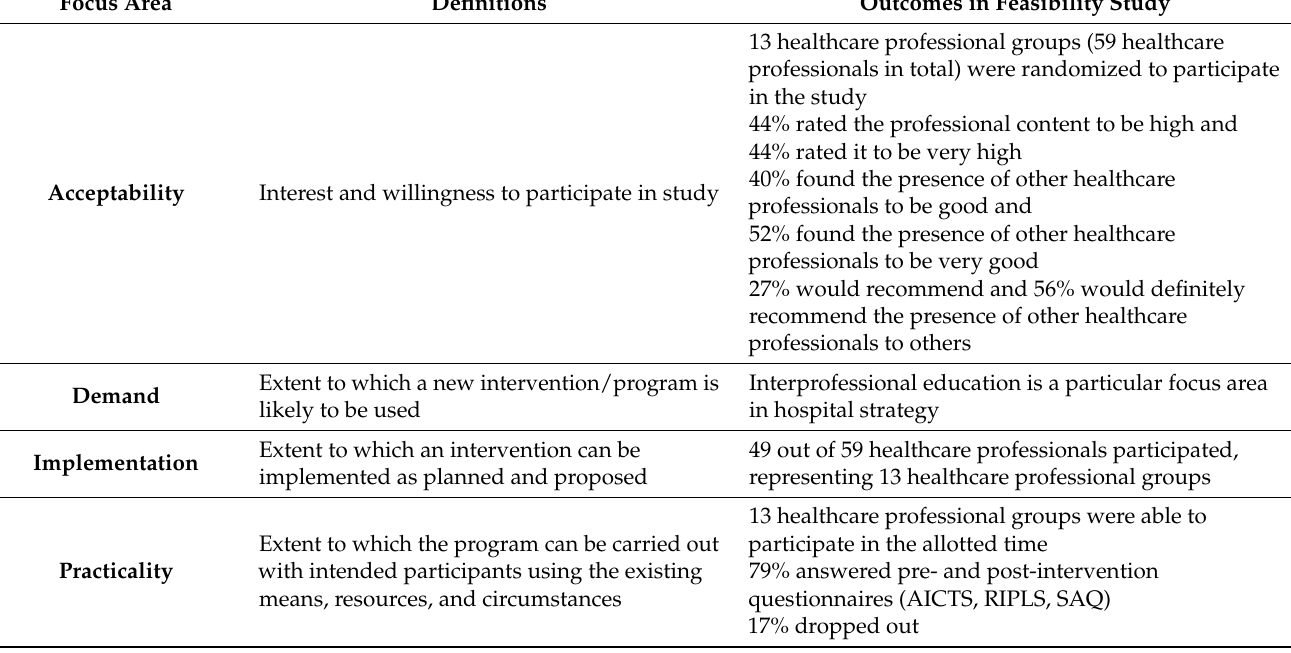
Table 3. Feasibility results based on Bowen et al.’s focus